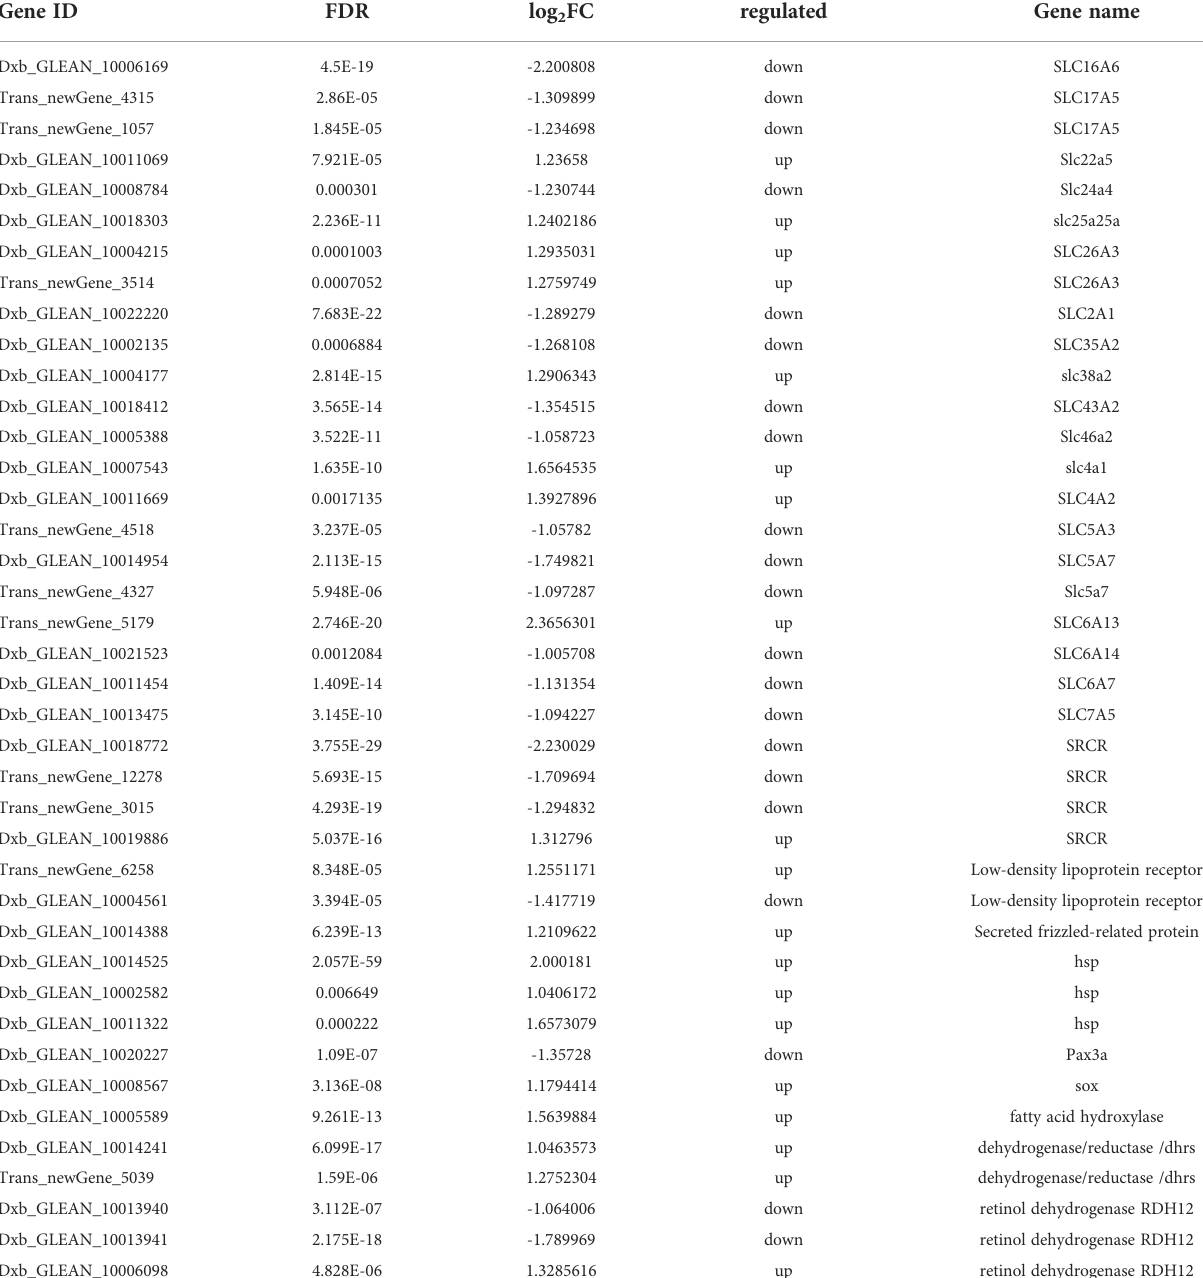
TABLE 1 DEGs associated with carotenoid metabolism. Gene